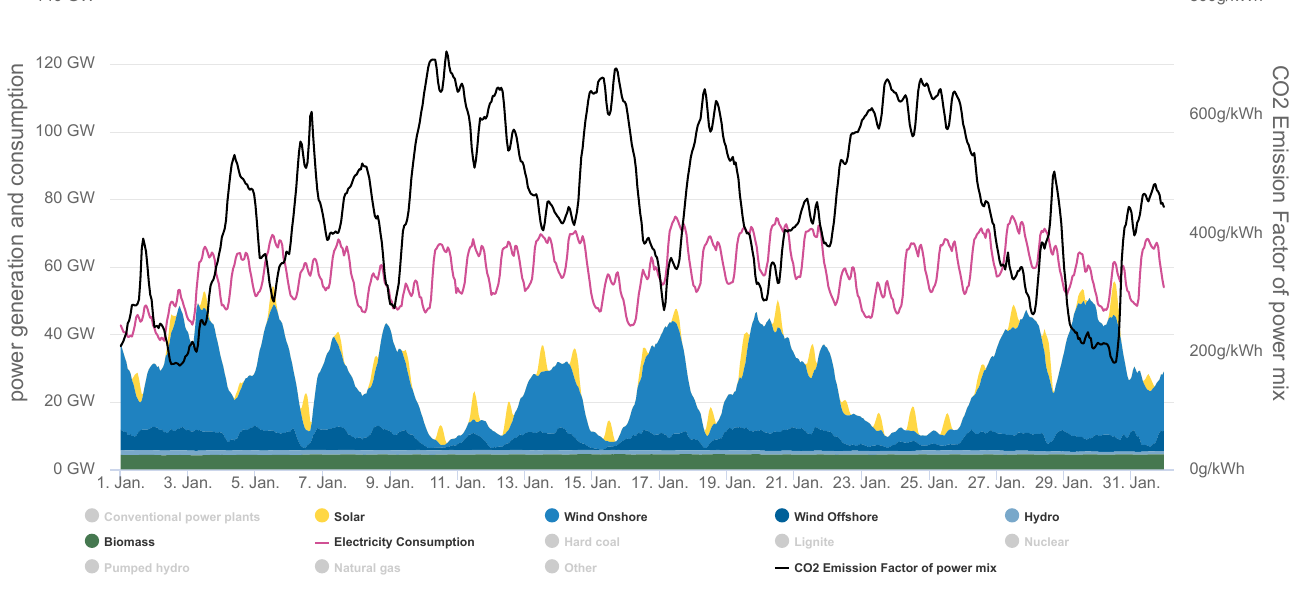
Figure 5. Example time series for electricity production and demand as well as resulting emissions attributed to grid electricity